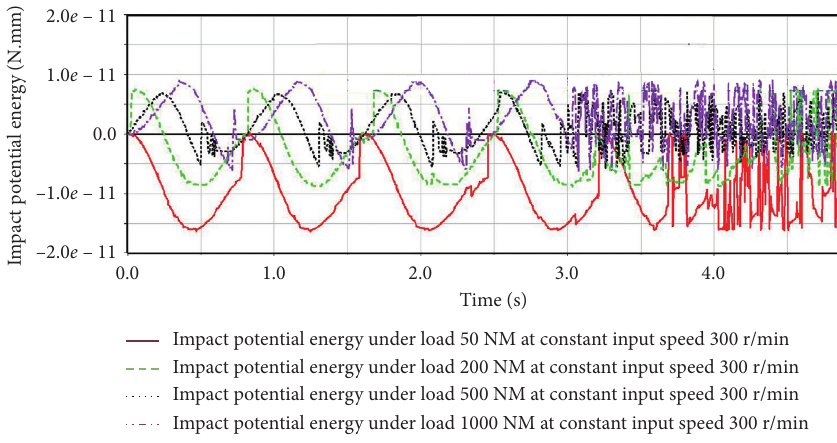
Figure 15: Impact potential energy of second-stage face gear pair under variable Table 4: Impact characteristics of second-stage face gear pair with no loading.